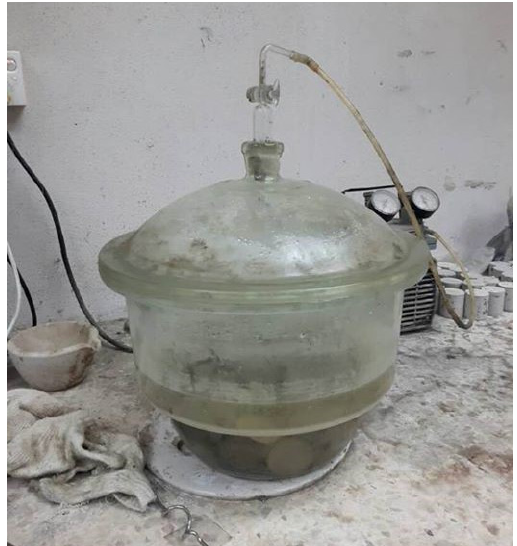
Figure 5. Porosity test via vacuum saturation